Question: Identify the chart type used in this figure.
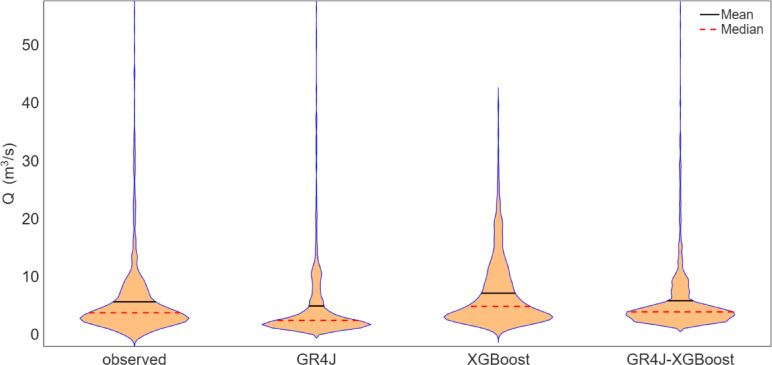
Answer: box